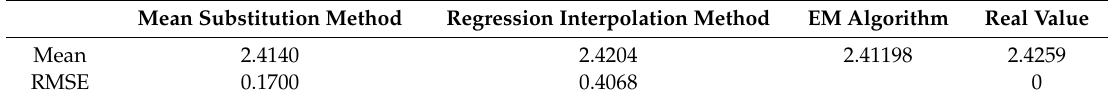
Table 3. Comparison of three data interpolation methods for a 30% missing rate.